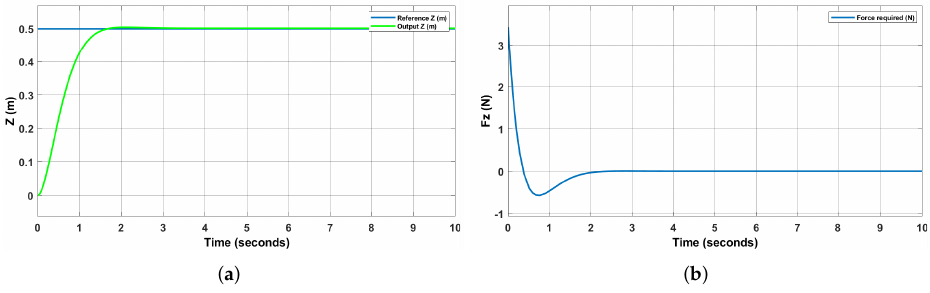
Figure 18. Response for Z transfer function with a step input of 0.5 m. ( a ) Z response. ( b ) Force required.